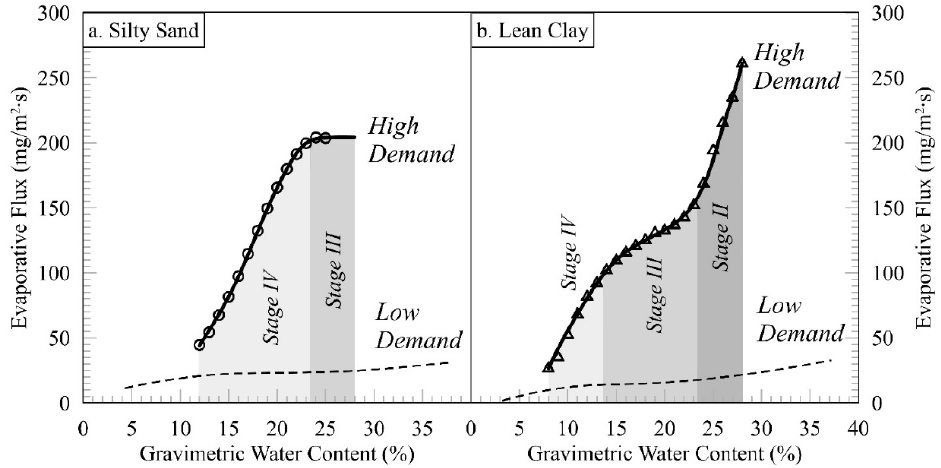
Figure 8. Evaporative flux under high demand for ( a ) silty sand and ( b ) lean clay.